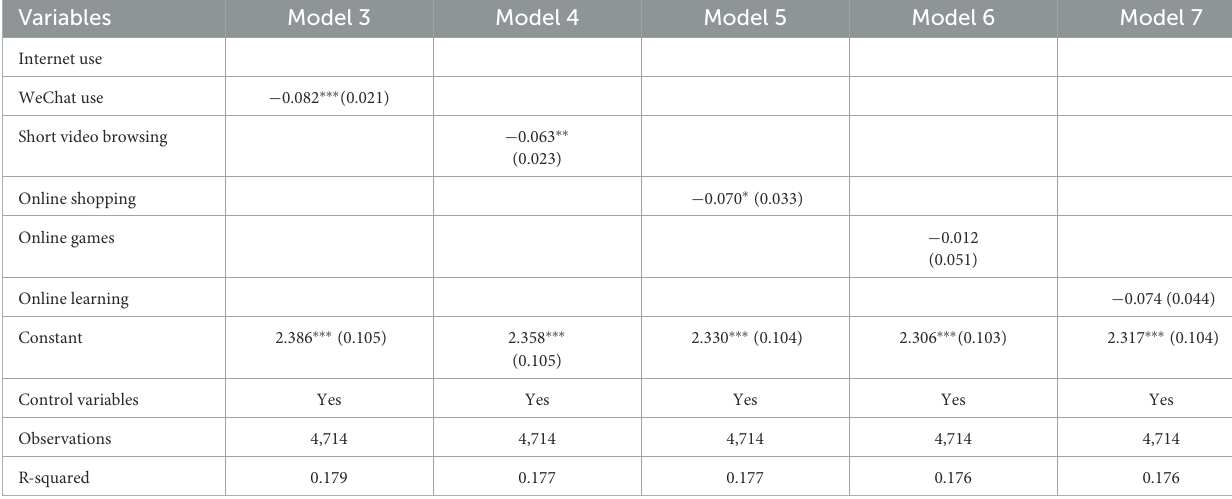
TABLE 5 The regression results on different internet usage and depression.